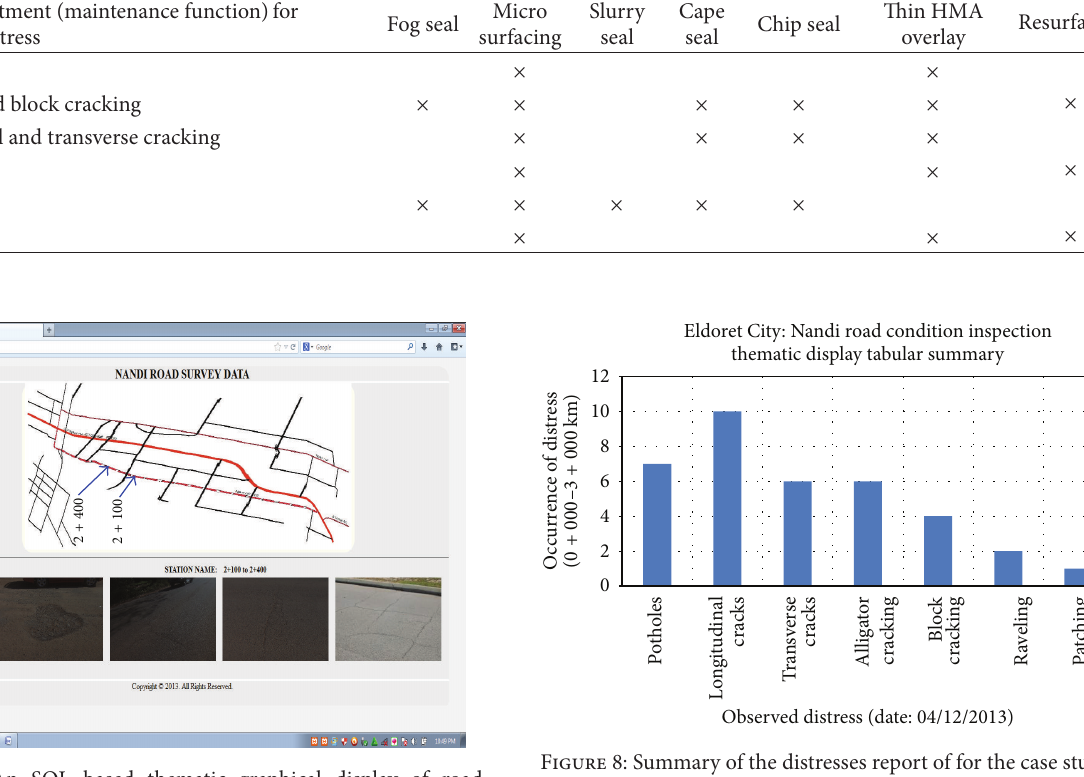
Figure 7: An SQL based thematic graphical display of road pavement distress at specified segments.